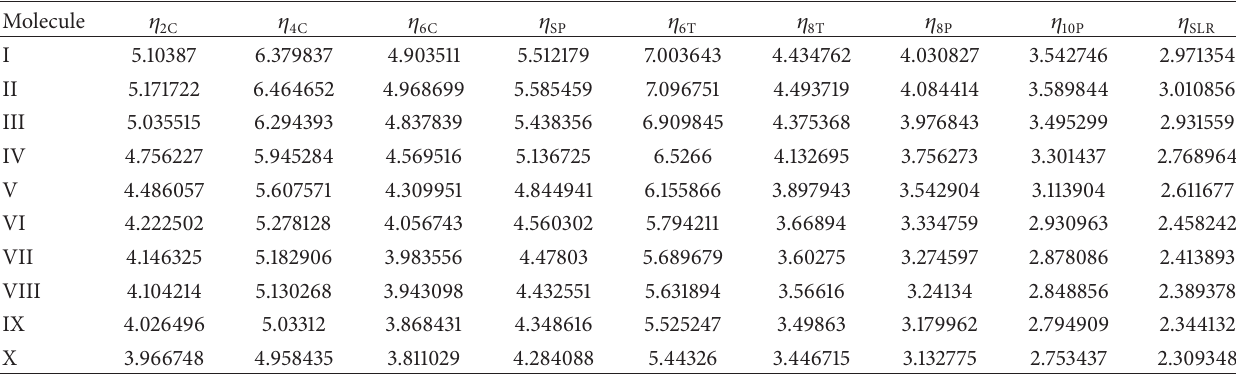
Table 3: Chemical hardness values (in eV) as computed for molecules of Table 2 with first-order LUMO(1)-HOMO(1) gap order of (21) with parameters of Table 1.